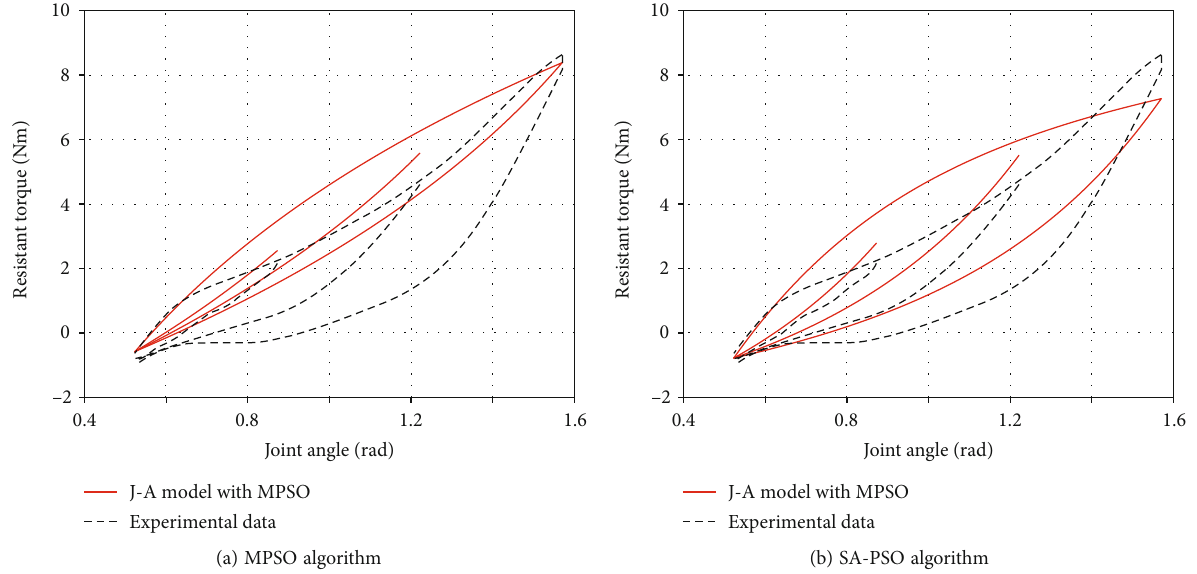
Figure 6: Comparison of resistant torque between elbow joints ’ experimental data and the J-A model with di ff erent PSO